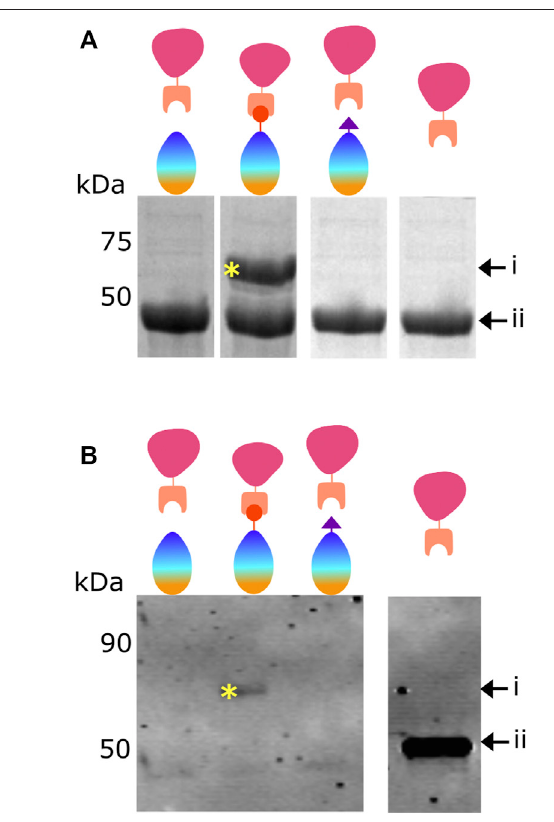
FIGURE 2 | Proteins bind to the BslA surface via a covalent bond. (A) Demonstration of covalent bond formation in solution. mCherry-SnC (44.8 kDa, labelled as ii) was incubated with BslA-WT, BslA-SnT, or BslA-SpT in solution and the products analysed by SDS-PAGE. A new protein band is seen at a molecular weight of approximately 60 kDa (labelled as i and with a yellow asterisk), only in the mCherry-SnC plus BslA-SnT reaction mix. Because it withstands the SDS-PAGE separation, the new band represents the covalently linked mCherry-SnC + BslA-SnT. Because mCherry-SnC protein is present in excess, bands corresponding to unreacted BslA proteins are not shown here for simplicity. The complete, uncropped SDS-PAGE gel is shown in Supplementary Figure S5 . (B) Demonstration of covalent bond formation to a surface. Surfaces of BslA-WT, BslA-SnT, or BslA-SpT on a hydrophobic glass surface were reacted with mCherry-SnC. Excess protein was removed and the surface gently washed. The surfaces were then vigorously washed with SDS loading buffer, to extract the BslA surface and any associated proteins, and the samples analysed by SDS-PAGE. Because the amounts of protein were low, a Western blot was performed, and the membrane probed with an anti-mCherry primary antibody. A band at approximately 60 kDa is evident only with the BslA-SnT plus mCherry-SnC, labelled with a yellow asterisk. Because it withstands the SDS-PAGE separation, we interpret the new band as representing the covalently linked mCherry-SnC + Bsla-SnT. Uncropped versions of both SDS-PAGE gel and Western blot are supplied in Supplementary Figure S5 .